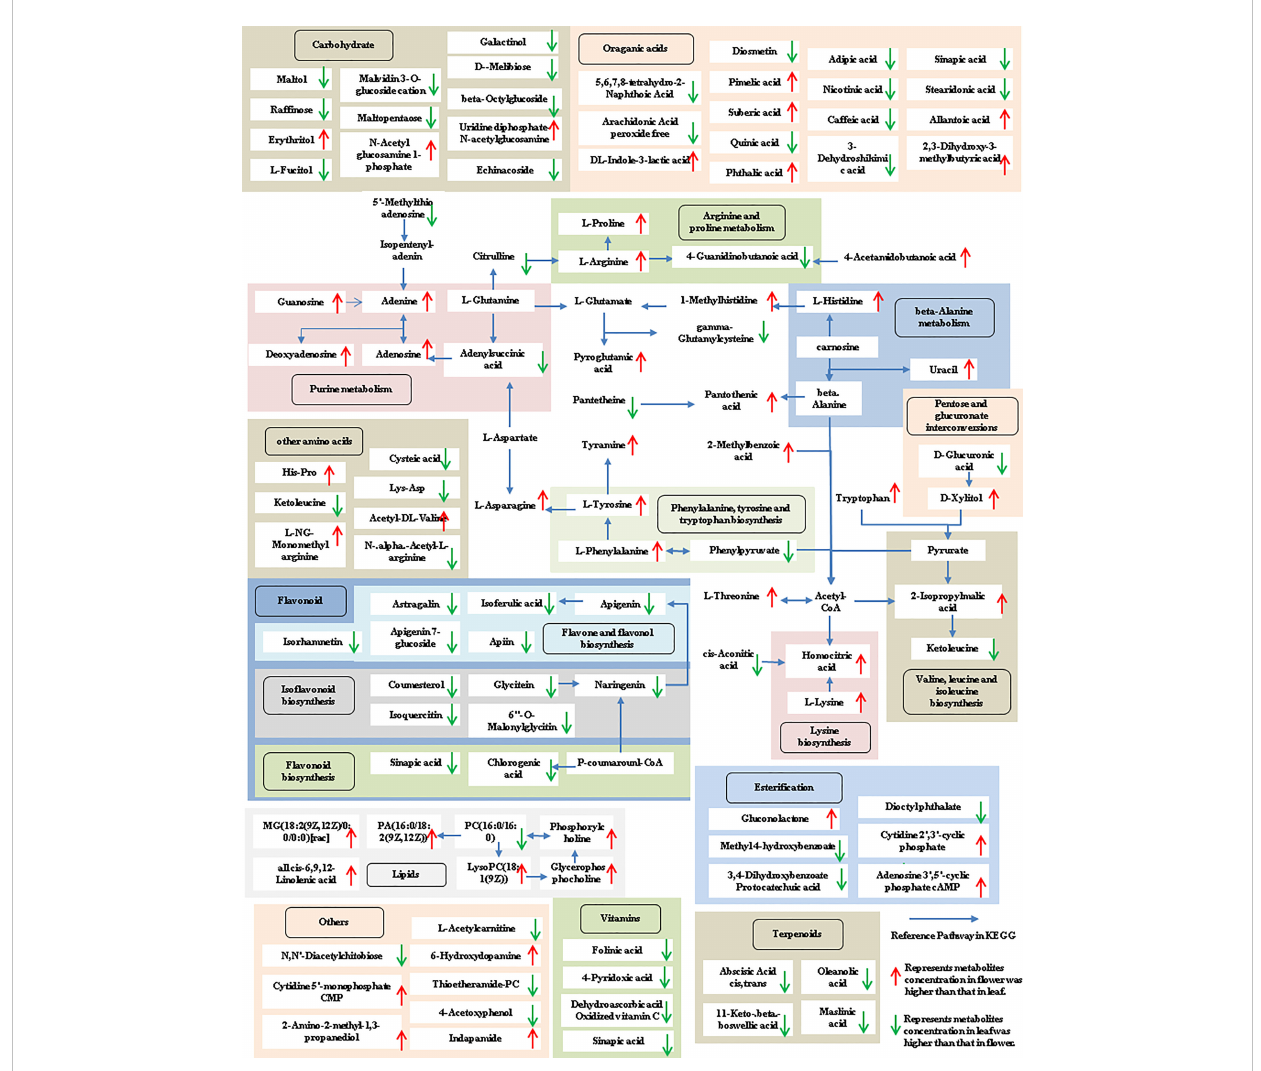
FIGURE 5 Metabolic pathways analysis in fl ower-leaf group of P. cablin . The 112 metabolites identi fi ed in fl ower-leaf group were mapped onto primary and secondary metabolism. The upward-pointing red arrows represent the value of |log2| (content fl ower/leaf) >1, which means the level of metabolites in fl ower is higher than that in leaf, the value of |log2|(content fl ower/leaf) <1 means the level of metabolites in leaf was higher than that in fl ower, and represented by downward-pointing green